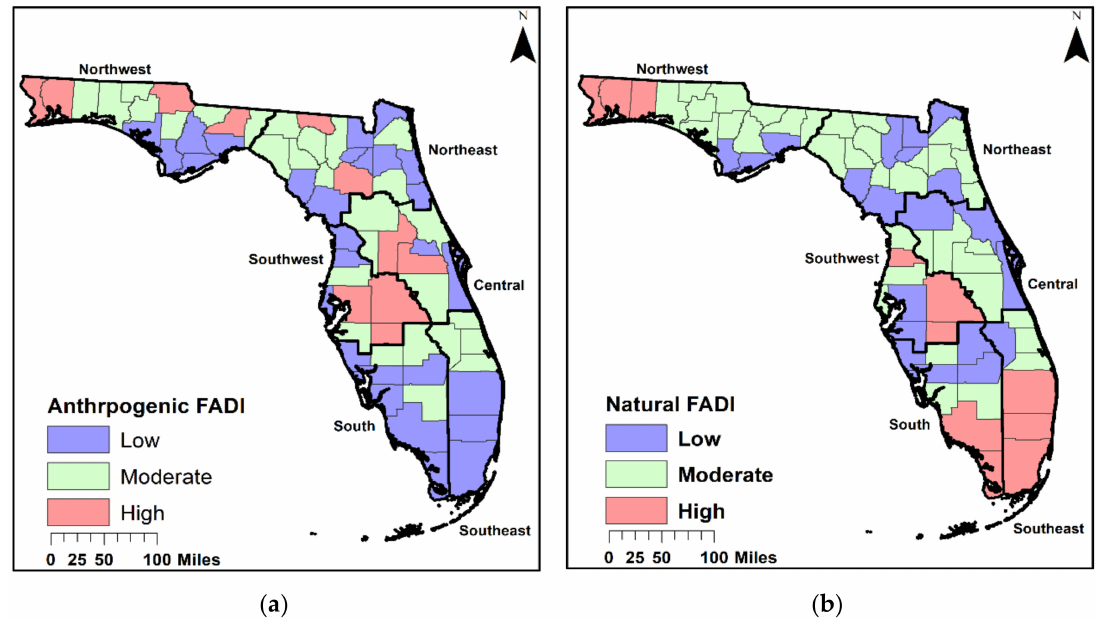
Figure 1. The Florida Arsenic Distribution Indices (FADIs): ( a ) anthropogenic source FADI; ( b ) natural source